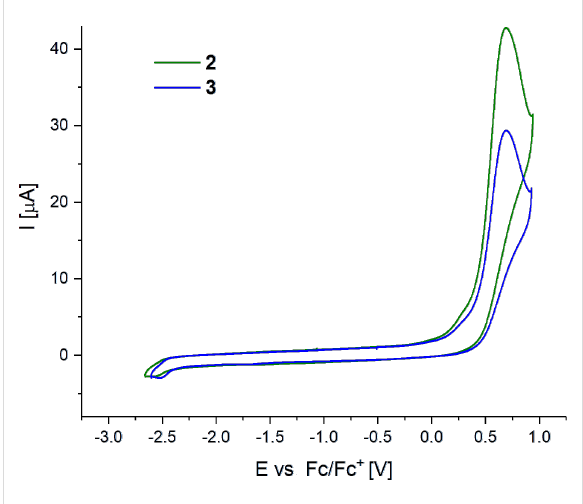
Figure 4: Cyclic voltammograms of complexes 2 and 3 , analyte con- centration 10 − 4 M. Measured in DMF (0.1 M TBAP) vs Fc, v = 100 mV/s, under N 2